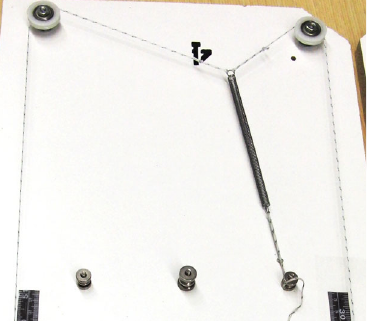
FIG. 2. The system we used in the PDM for the expert interviews. The system contains a single spring, attached by string to an off-center post. The “ observable ” strings are routed around two horizontal pulleys towards the front of the machine where they are measured, and are attached to